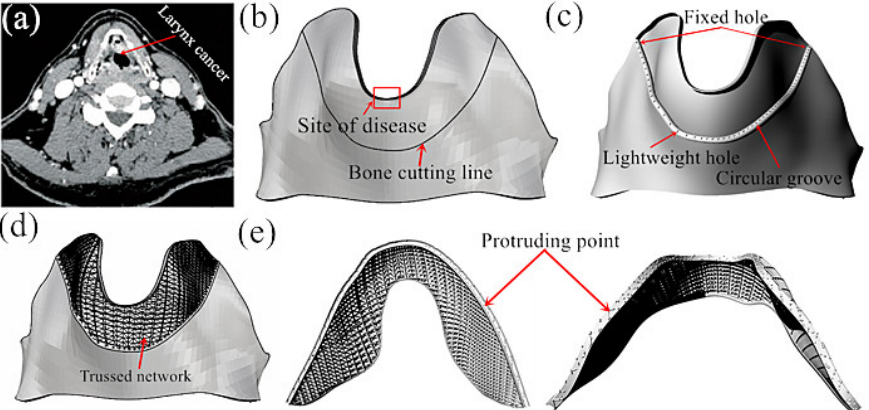
Figure 6. The design process of total removal of multi-layer mesh thyroid cartilage prosthesis: ( a ) CT model; ( b ) simulated osteotomy; ( c ) opening position of fixed hole; ( d ) line model; ( e ) volume